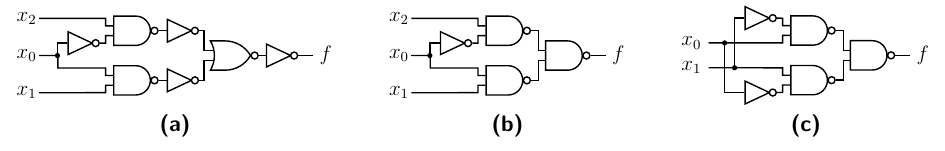
Figure 1: Low-latency implementation of a MUX2 and an XOR